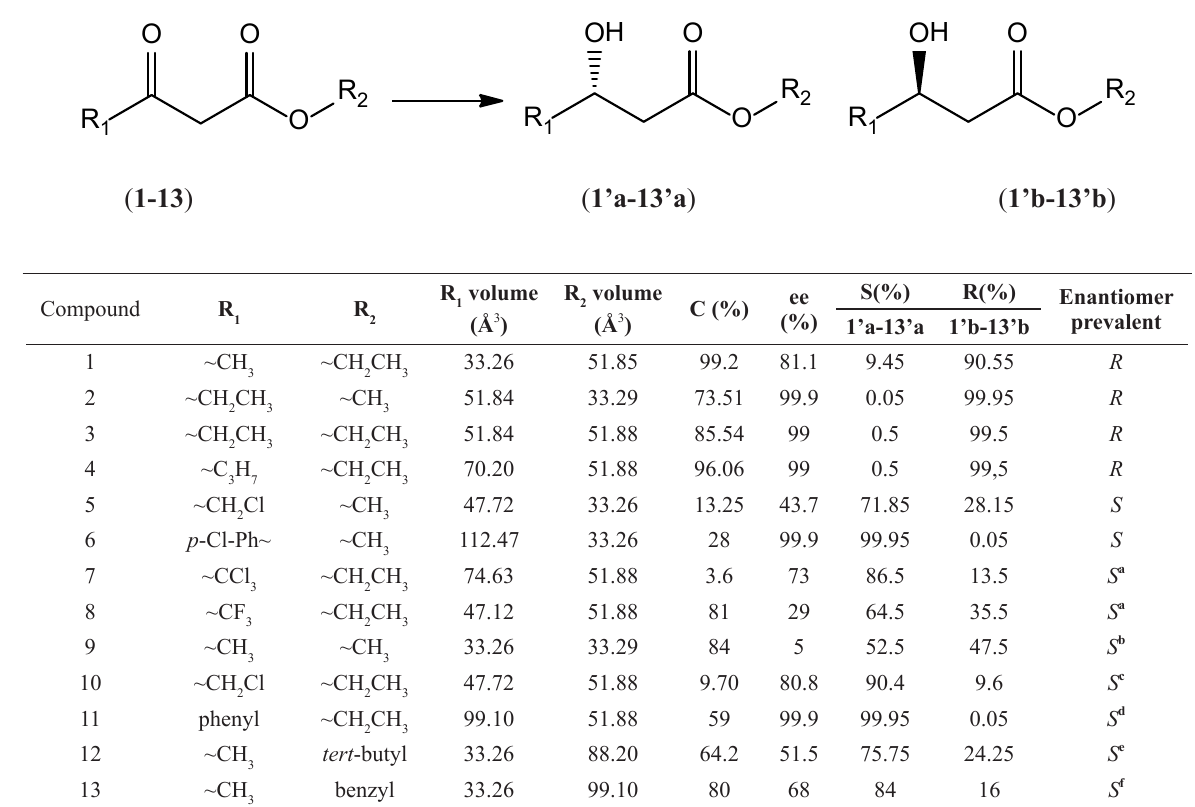
Bioconversion of β-ketoesters series (1-13) by Kluyveromyces marxianus to correspondent ( S )-(1’a-13’a) or ( R )-hydroxyesters